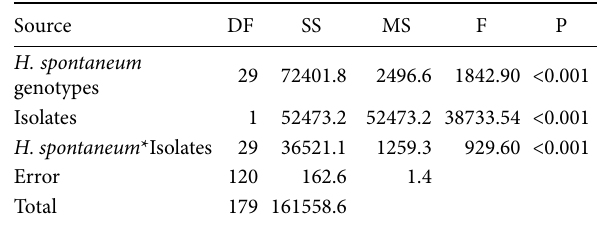
Table 2. Analysis of variance for the resistance of 30 Hordeum spon- taneum genotypes 60 d after planting following seed inoculation with two isolates of Drechslera